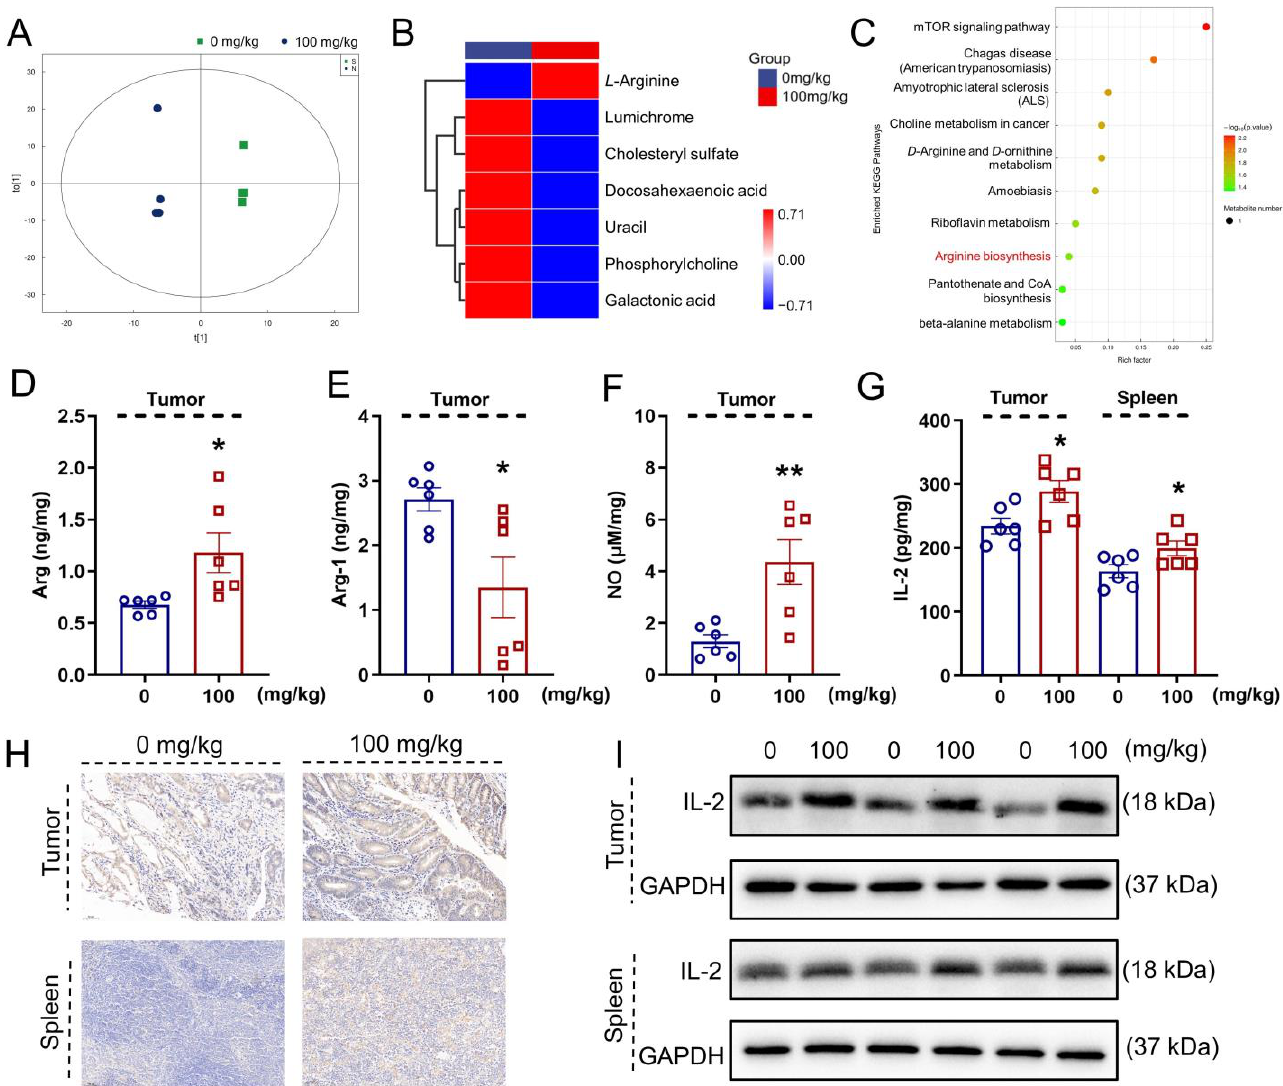
Figure 3. IHS regulates serum metabolites of Apc Min/+ mice. ( A ) OPLS-DA was used to analyze differences in serum metabolites between vehicle- and IHS-treated mice; ( B ) Cluster heat map of differential metabolites; ( C ) KEGG enrichment pathway bubble map. IHS increased the level of ( D ) Arg and ( F ) NO, and decreased the level of ( E ) Arg-1 in tumors, as analyzed using ELISA ( n = 6); ( G – I ) IHS enhanced the expressions of IL-2 in tumors and in the spleen of Apc Min/+ mice, as analyzed using ( G ) ELISAs ( n = 6), ( I ) Western blotting, and ( H ) IHC (20 ×, 50 μm). Data were analyzed using a one-way ANOVA and are shown expressed as means ± SEM. * p < 0.05, ** p < 0.01 vs . vehicle-treated mice.